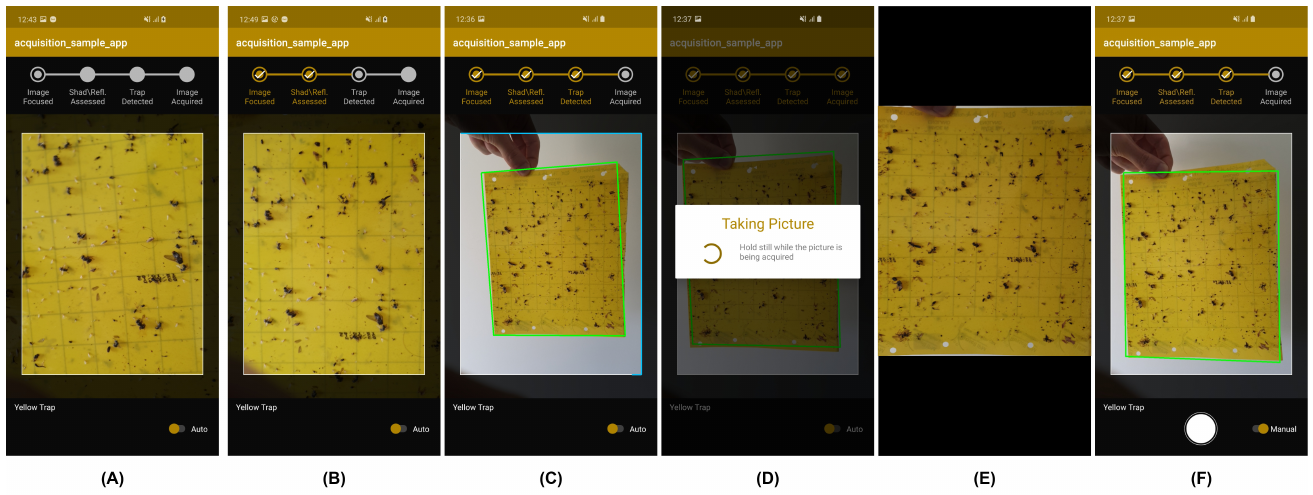
Figure 10. Android application screenshots: ( A ) unfocused image; ( B ) focused and good illumination; ( C ) trap detected; ( D ) automatic image capture; ( E ) perspective correction; and ( F ) manual mode.